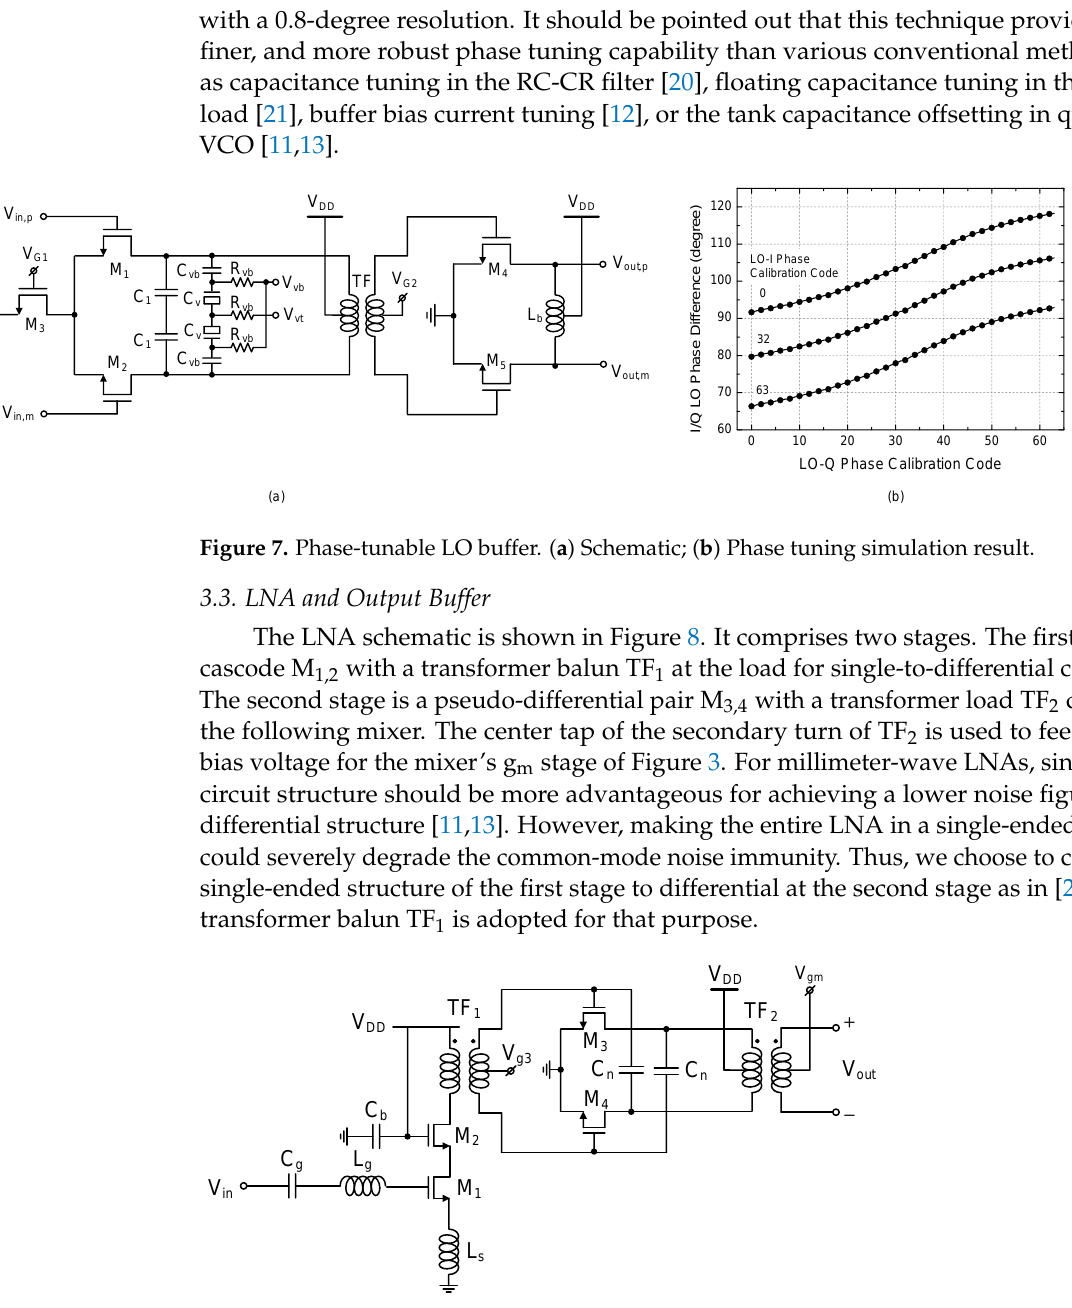
Figure 9. Baseband amplifier (BBA). 4. Implementation Results The 24 GHz RF receiver IC of Figure 2 is fabricated in a 65 nm RF CMOS process. A micrograph of the fabricated chip is shown in Figure 10a. The die size is 1.71 × 1.15 mm 2